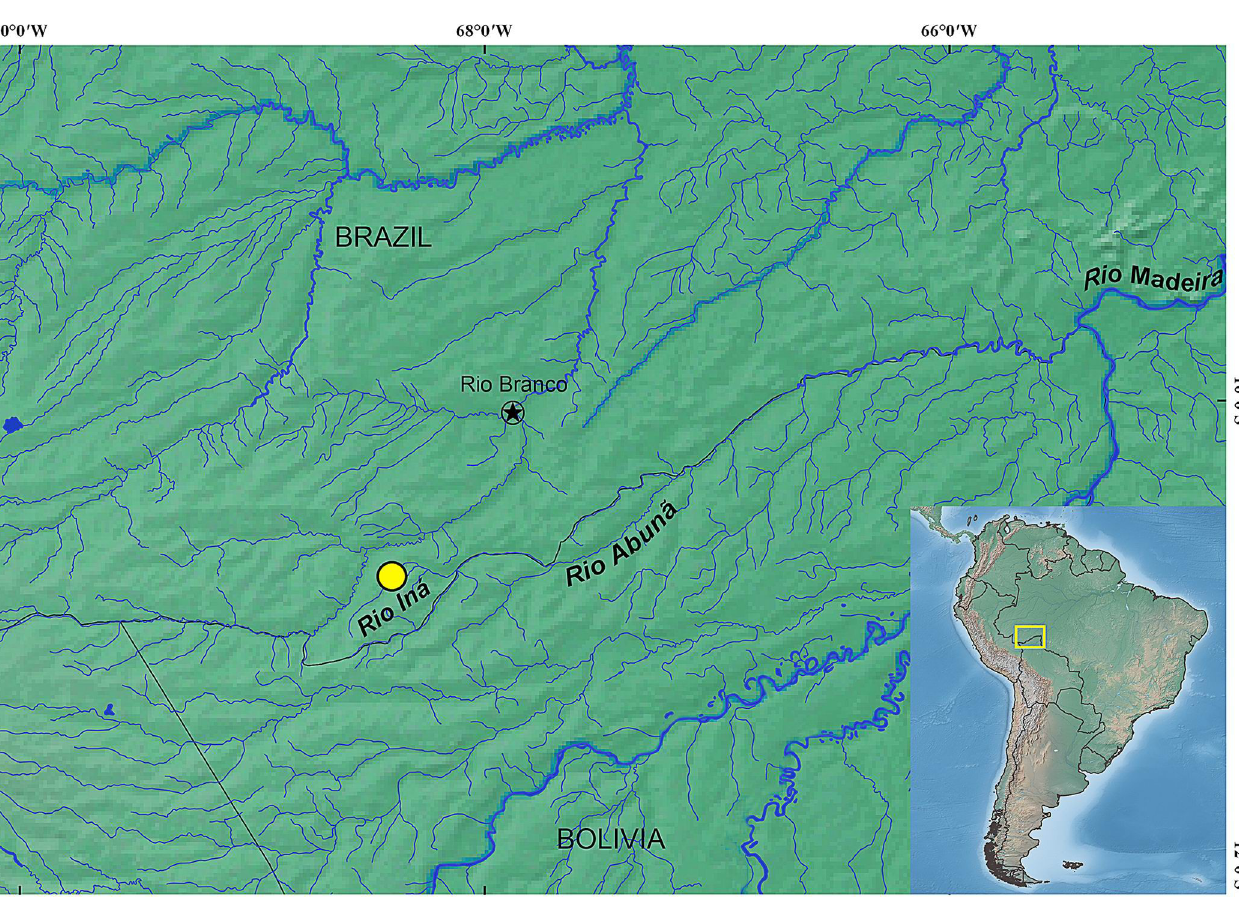
Fig 7. Distribution of Tyttobrycon shibattai (yellow circle). Rio Ina´, tributary of Rio Abun ã , Rio Madeira drainage, Rio Amazonas basin, Seringal Cachoeira road, Xapuri, Acre, Brazil. Made with Natural Earth. Free vector and raster map data @ naturalearthdata.com.